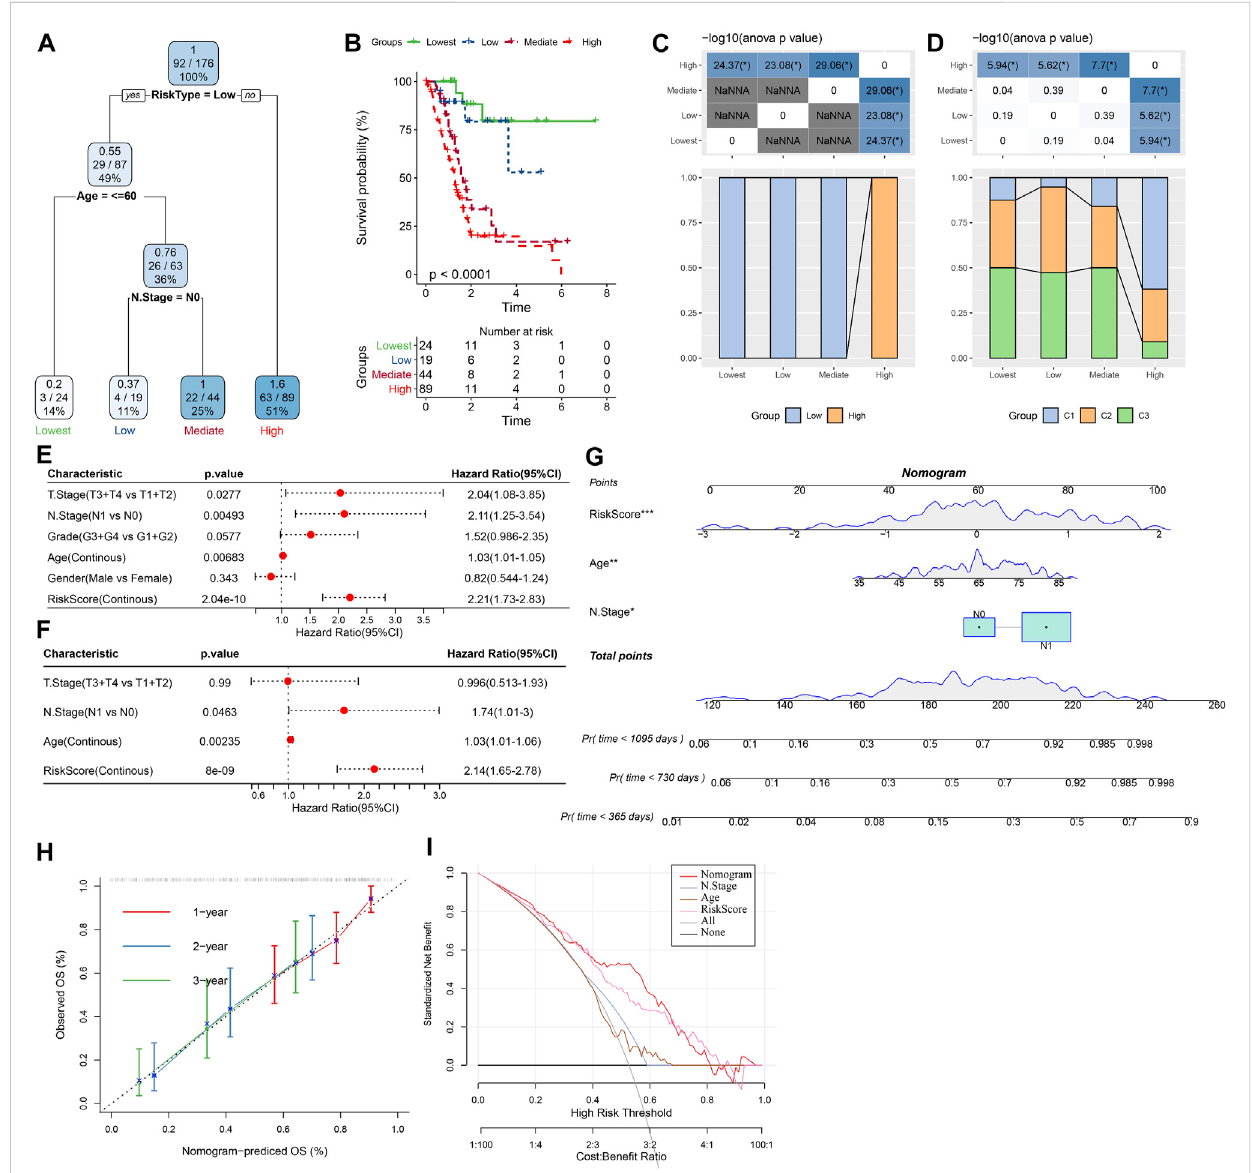
FIGURE 12 Construction of prognostic models of PC using the risk score and clinicopathological features. (A) A decision tree model generated four risk groups basedonage,Nstageandtheriskscore. (B) Survivalanalysisofthedecisiontree-derivedriskgroupsshowingdistinctprognosesamongthegroups. (C,D) showed the correlations between risk score-derived groups and decision tree-derived groups. (E) and (F) Univariate and multivariate Cox analysis of risk scoreandclinicopathologicalcharacteristics. (G) Thenomogrammodelconsistsofage,Nstage,andtheriskscore; (H) 1-,2-,and3-yearcalibration curves of the established nomogram; (I) The decision curves showing the capacity for survival